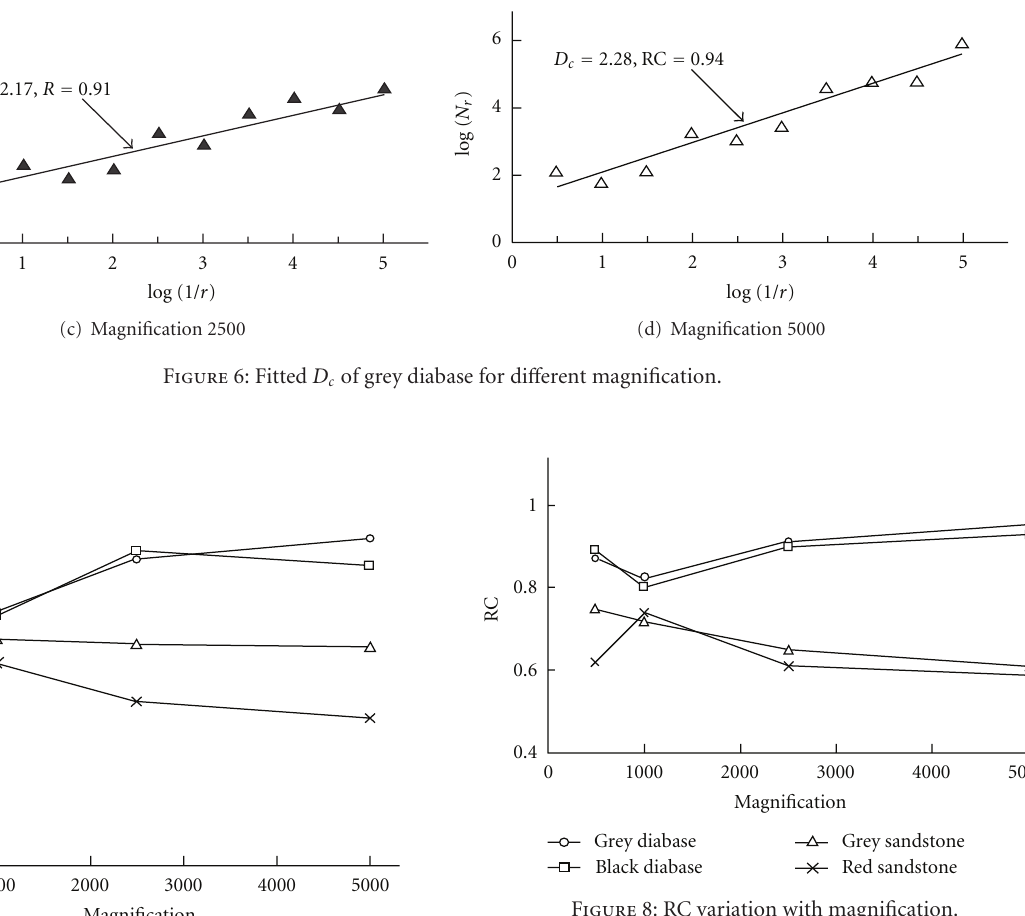
Figure 8: RC variation with